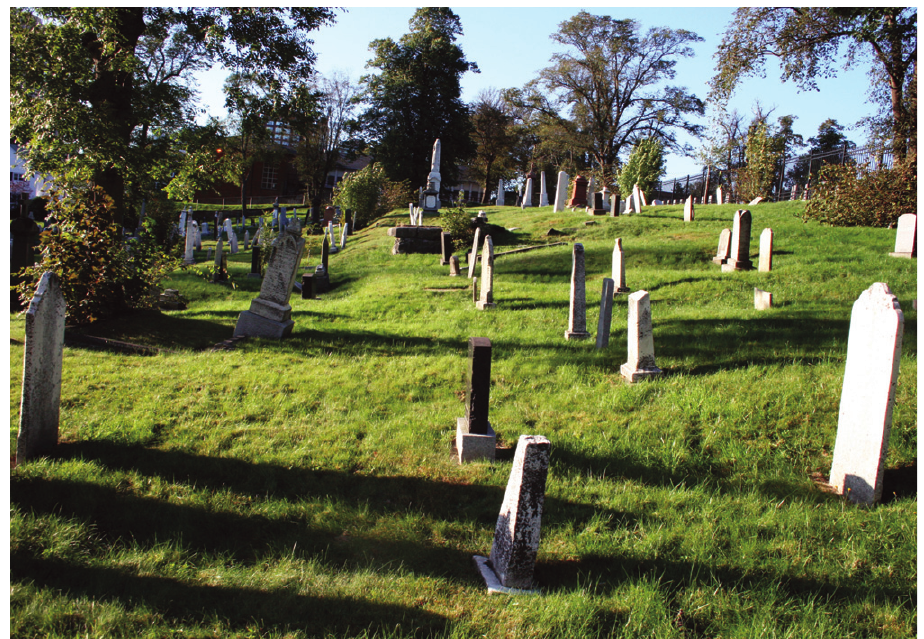
Figure 3. Photograph of the habitat at the Holy Cross site where Phosphaenus hemipterus specimens were collected. Photo credit: Christopher